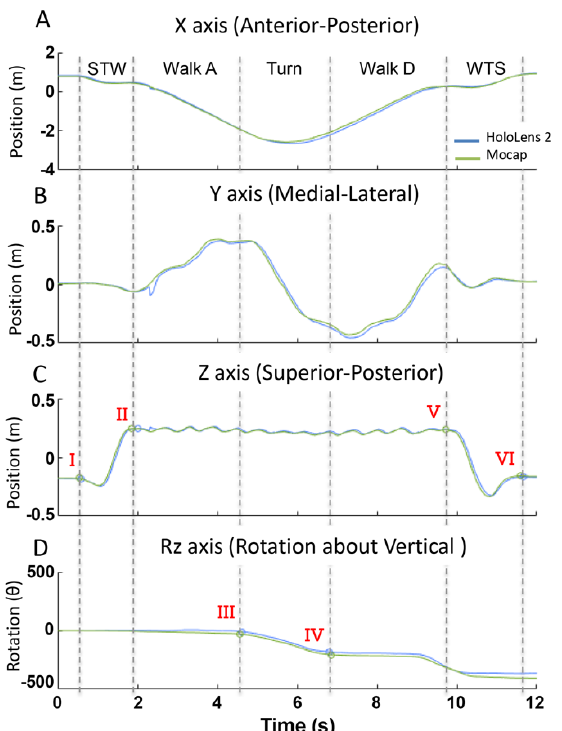
Figure 2. Position ( A – C ) and rotation ( D ) data from the MoCap (green) and HL2 (blue) from a representative TUG trial. The five phases of the TUG were segmented (dashed vertical lines) using the vertical position data ( A ) and vertical rotation data ( D ) and included: sit-to-walk (STW), gait ascend (Gait-A), turn, gait descend (Gait-D), and walk-to-sit (WTS). Points I–V are time points used in the algorithm to segment the trial.